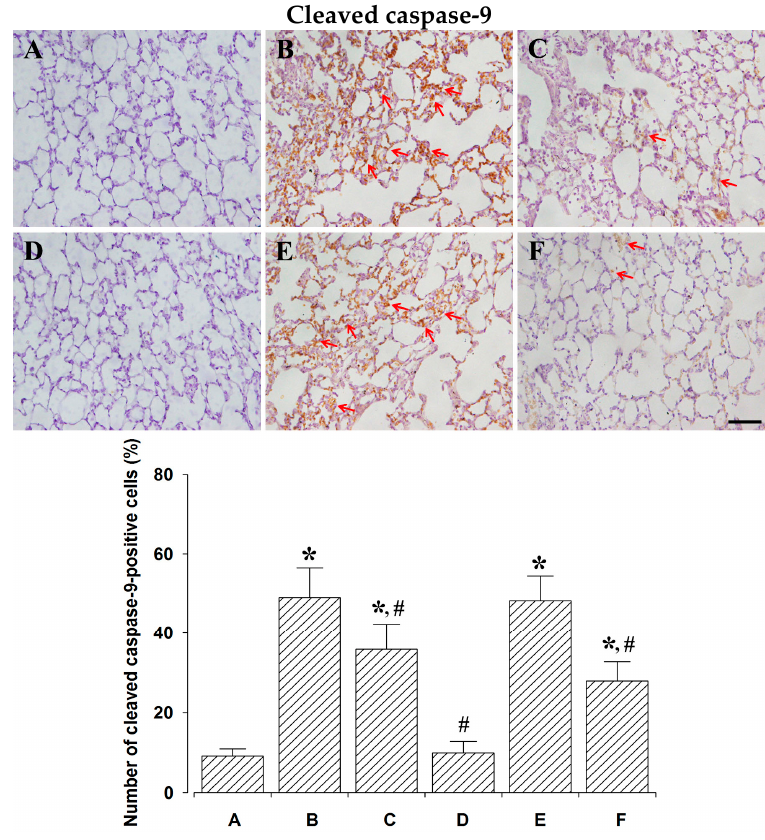
Figure 3. The effect of polydeoxyribonucleotide (PDRN) treatment on the percentages of cleaved caspase-3-, -8-, -9-positive cells. Upper : Cleaved caspase-3-positive cells. ( Top ) Photomicrographs of cleaved caspase-3-positive cells. ( Down ) Percentages of cleaved caspase-3-positive cells in each group. Middle: Cleaved caspase-8-positive cells. ( Top ) Photomicrographs of cleaved caspase-8-positive cells. ( Down ) Percentages of cleaved caspase-8-positive cells in each group. Lower: Cleaved caspase-9-positive cells. ( Top ) Photomicrographs of cleaved caspase-9-positive cells. ( Down ) Percentages of cleaved caspase-9-positive cells in each group. The scale bar represents 100 µ m. Red arrows represent cleaved caspase-positive cells. ( A ) Control and 24 h after sacrifice group; ( B ) lung injury and 24 h after sacrifice group; ( C ) lung injury with PDRN-treatment and 24 h after sacrifice group; ( D ) control and 72 h after sacrifice group; ( E ) lung injury and 72 h after sacrifice group; ( F ) lung injury with PDRN-treatment and 72 h after sacrifice group. * represents p < 0.05 compared to the control and 24 h after sacrifice group. # represents p < 0.05 compared to the lung injury and 24 h after sacrifice